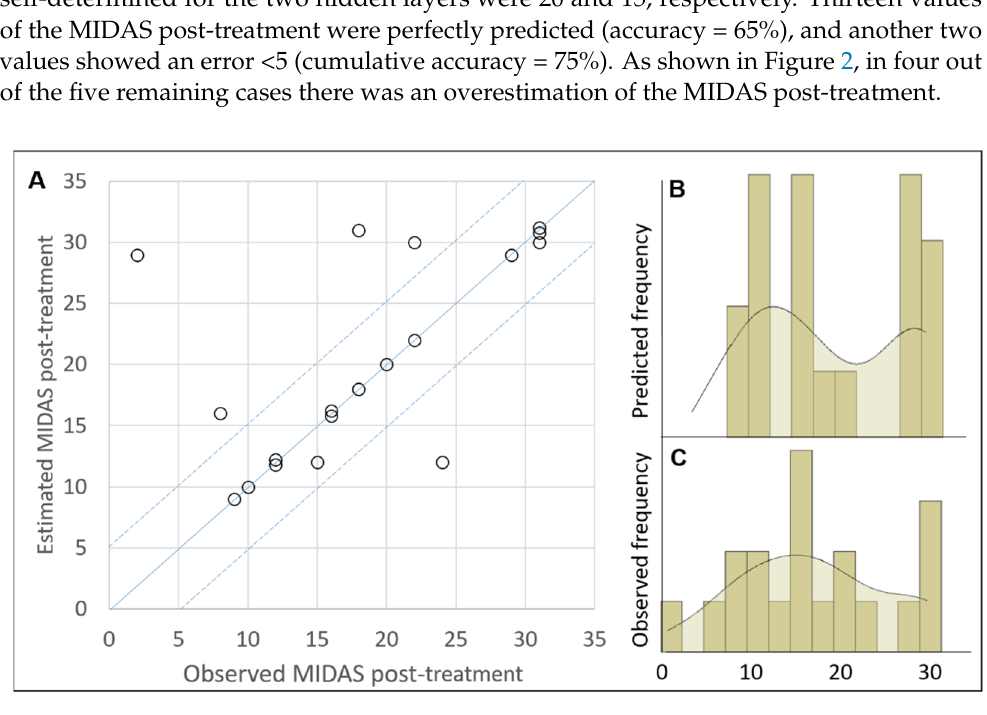
Figure 2. The results of the artificial neural network. Panel ( A ) Observed vs. estimated MIDAS post- treatment; the blue solid line represents the perfect prediction; the dotted line represents a tolerance of 5. Panel ( B ) Frequency distribution of predicted MIDAS. Panel ( C ) Frequency distribution of observed MIDAS.